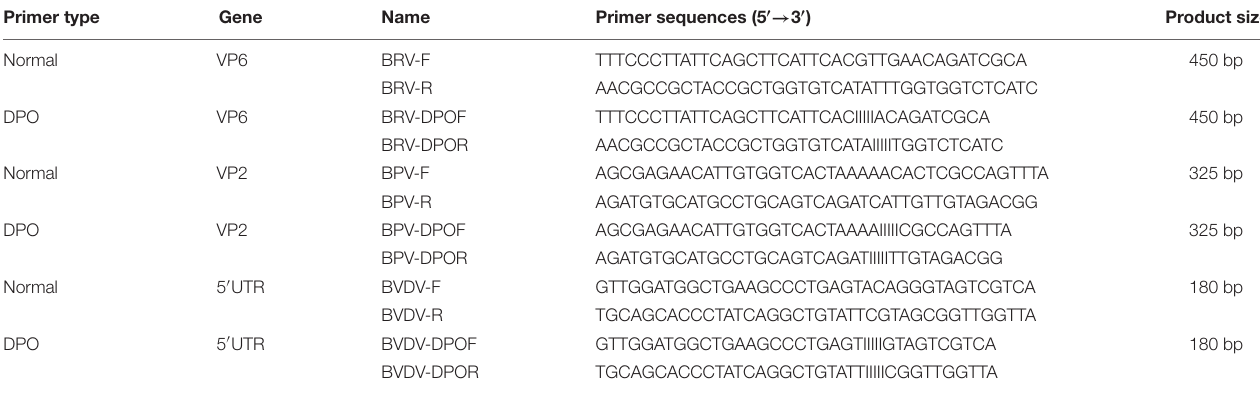
TABLE 1 | Primers used for DPO-nanoPCR and conventional PCR.